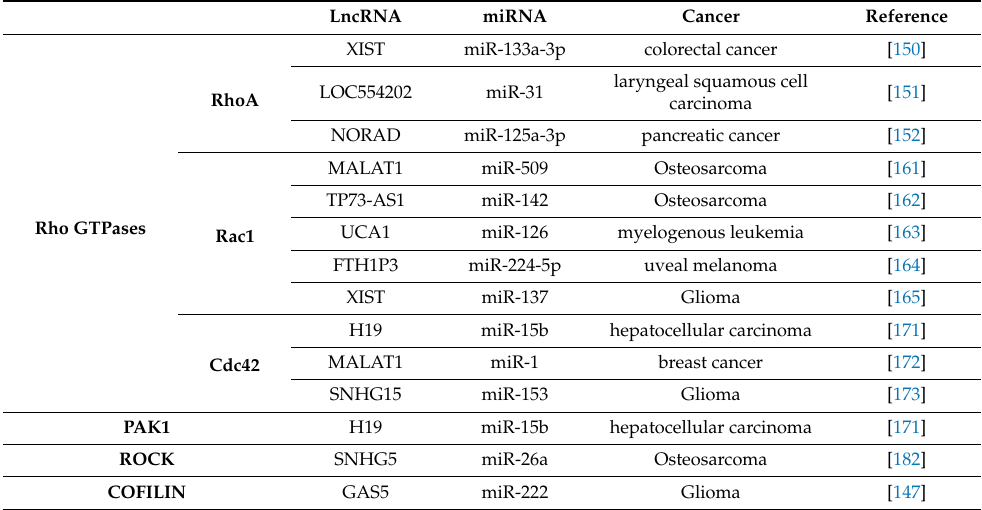
Table 3. Long non-coding RNAs (lncRNAs) as competitive endogenous RNAs (ceRNAs) of miRNAs in regulation of the actin